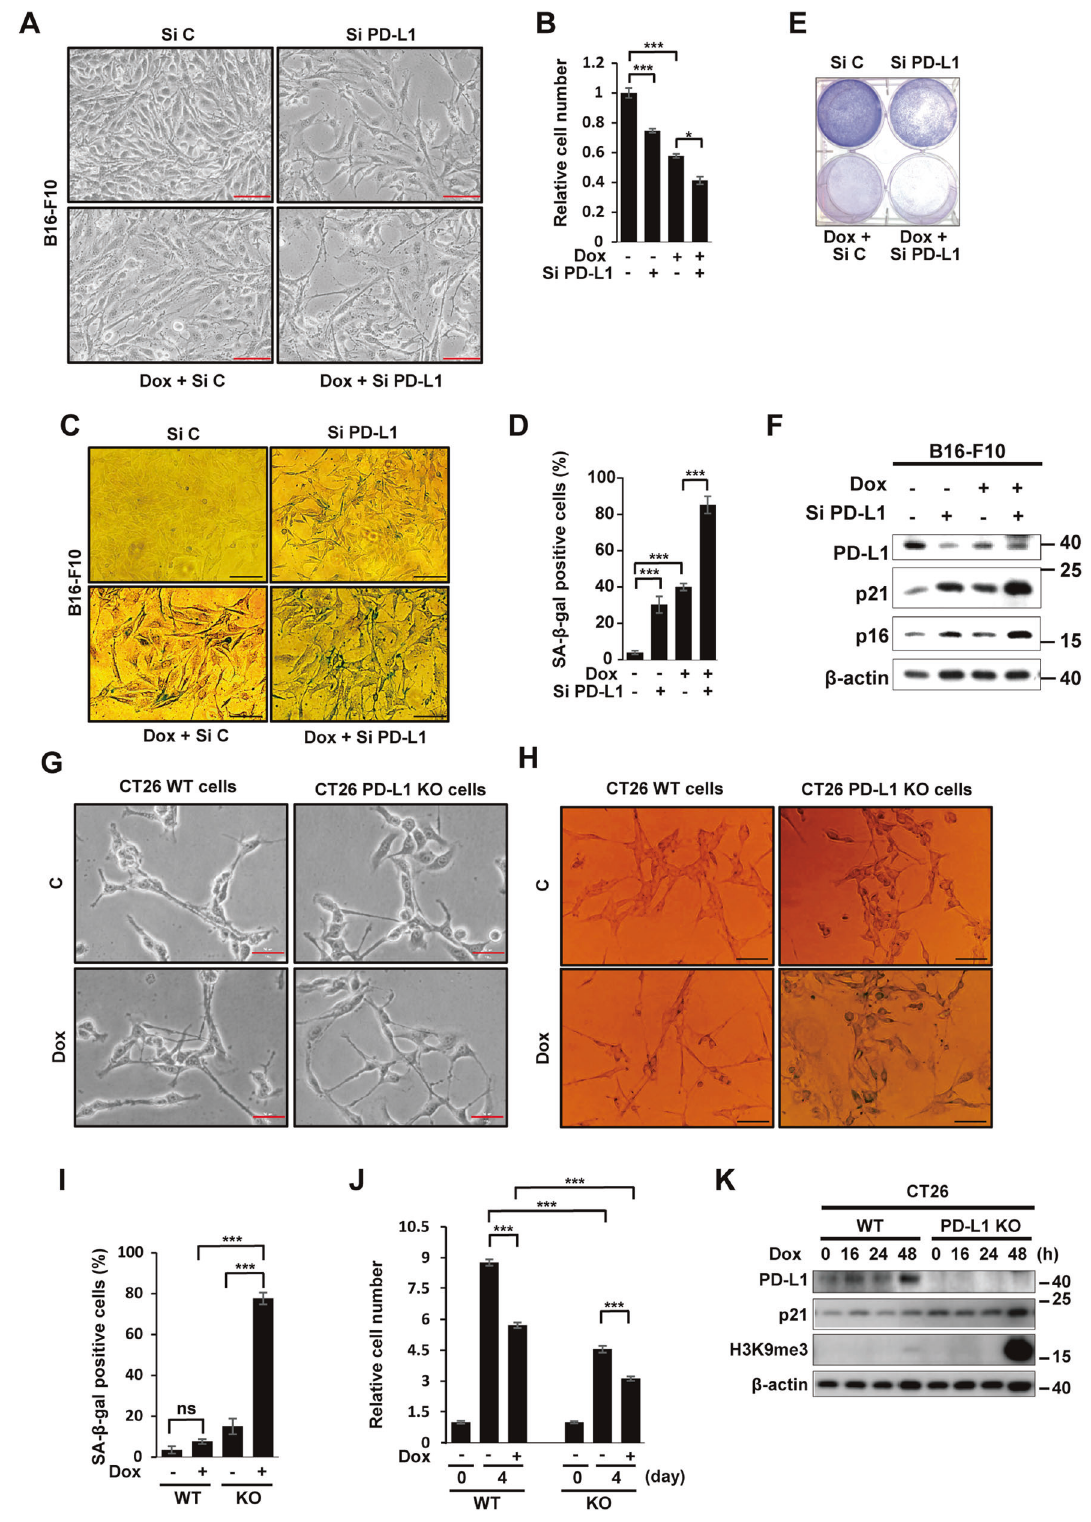
Fig. 2 PD-L1 depletion accelerates Dox-induced senescence. A – F B16-F10 cells were transfected with 100 nM Control (siC) or PD-L1 (siPD-L1) siRNA prior to treatment with 100 ng/mL Dox. The morphological changes ( A ), relative cell numbers ( B ), and SA- β -Gal-positive cells were evaluated in 100 cells ( C , D ). The colony-forming assay was performed on day 7 ( E ) and western blot analysis ( F ) of the indicated proteins was performed on day 3 post-Dox treatment. Parent and PD-L1 KO CT26 cells were treated with 100 ng/mL Dox for 3 days ( G – K ) and imaged under a phase-contrast microscope ( G ). SA- β -Gal-positive cells from 100 cells ( H , I ) were counted. Relative cell numbers were quanti fi ed ( J ) on days 0 and 4 after Dox treatment, and western blotting was performed at the indicated time points after treatment ( K ). β -actin was detected as a loading control. Scale bars = 50 μ m ( A , C , G , H ). The signi fi cance of the statistical difference among three group was calculated using a one- way analysis of variance and Newman-Keuls. Quantitative data are expressed as means ± SD . ns, not signi fi cant. * P < 0.05. *** P < 0.001. Cell Death and Disease (2022)